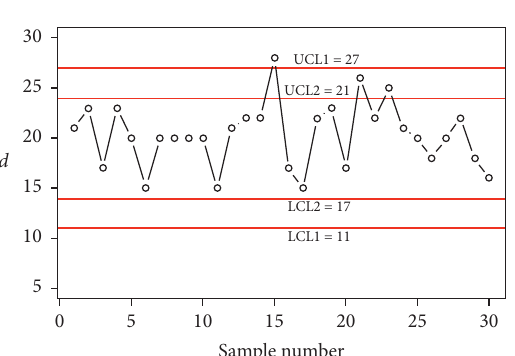
Figure 1: The Birnbaum–Saunders chart based on the MDSRS method for simulated data.